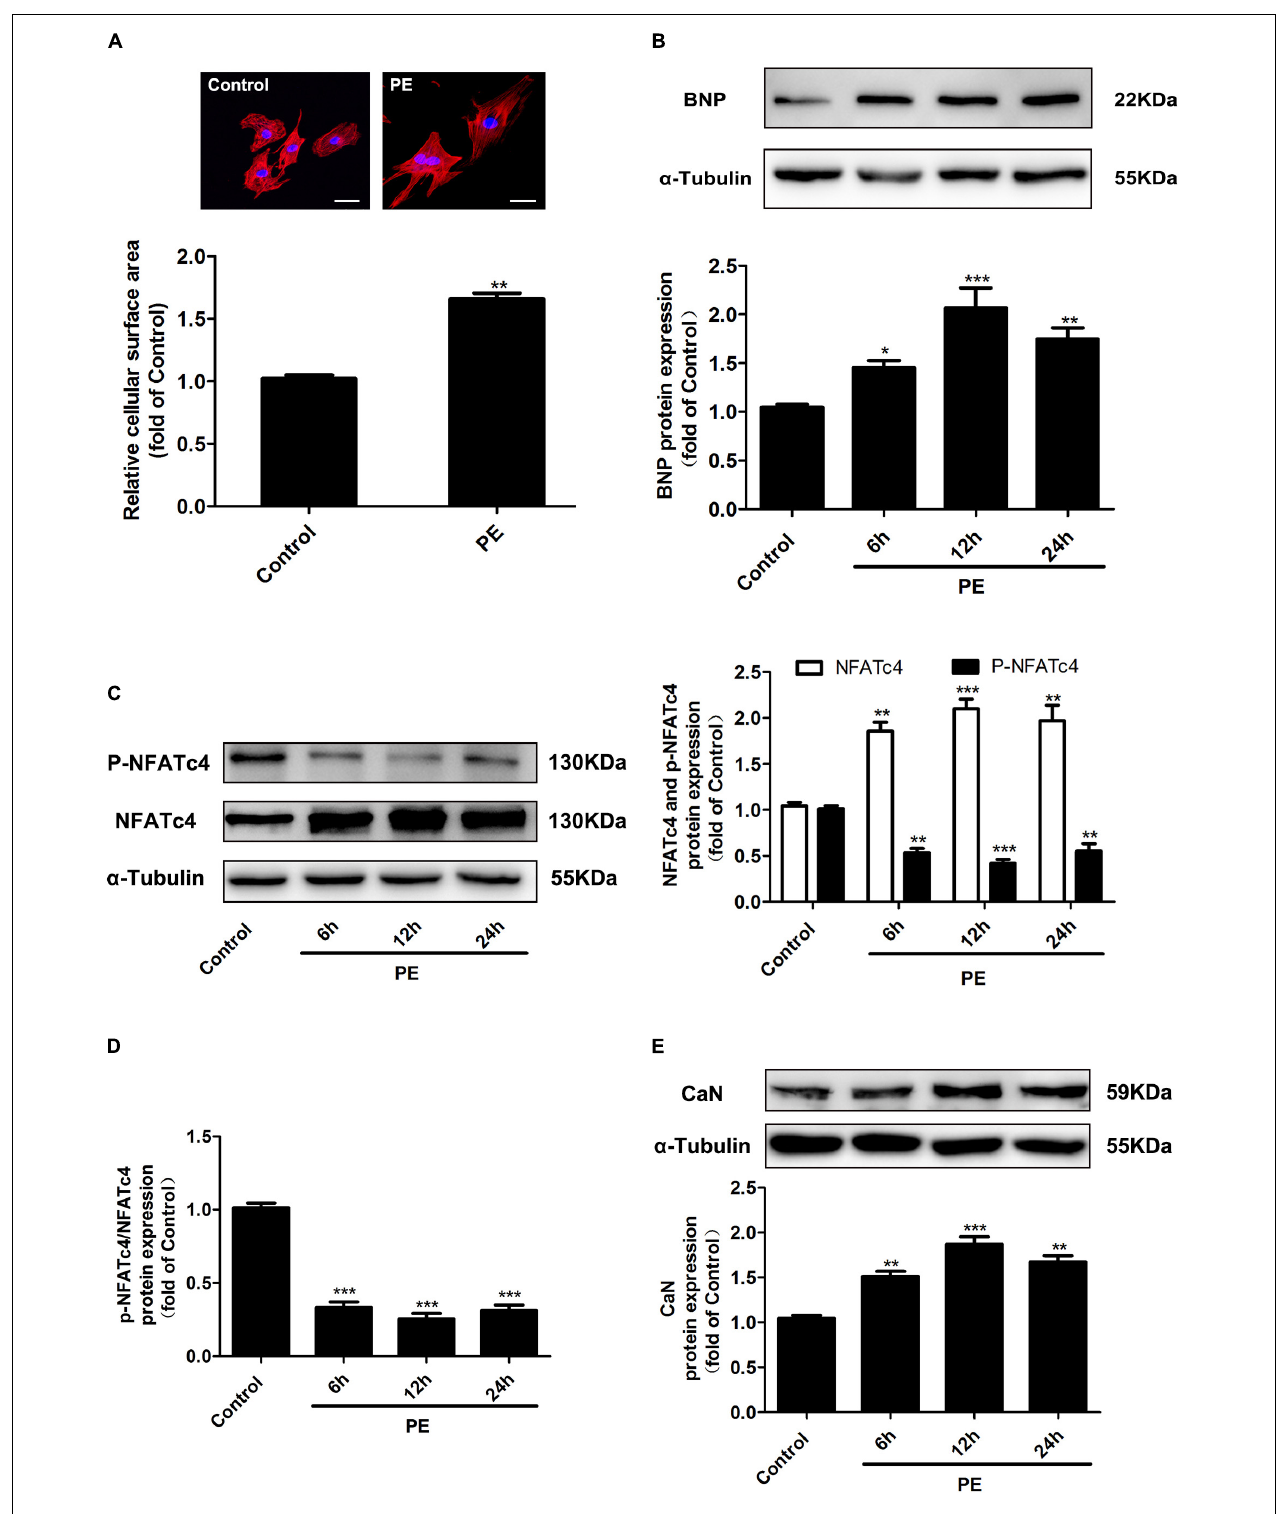
FIGURE 1 | Changes of NFATc4 expression in PE-induced cardiac hypertrophy in vitro . Cultured NRCMs were incubated with 100 µ M PE for the indicated durations. (A) The cell surface area was measured by rhodamine-phalloidin staining. Scale bar: 20 µ m. Western blotting analysis was conducted to determine the protein expression of (B) BNP, (C) total NFATc4 and phosphorylated NFATc4, (D) p-NFATc4/NFATc4 ratio, and (E) calcineurin in NRCMs treated with 100 µ M PE. The data were presented as mean ± SEM. ∗ P < 0.05, ∗∗ P < 0.01, ∗∗∗ P < 0.001 vs. Control, n = 4.